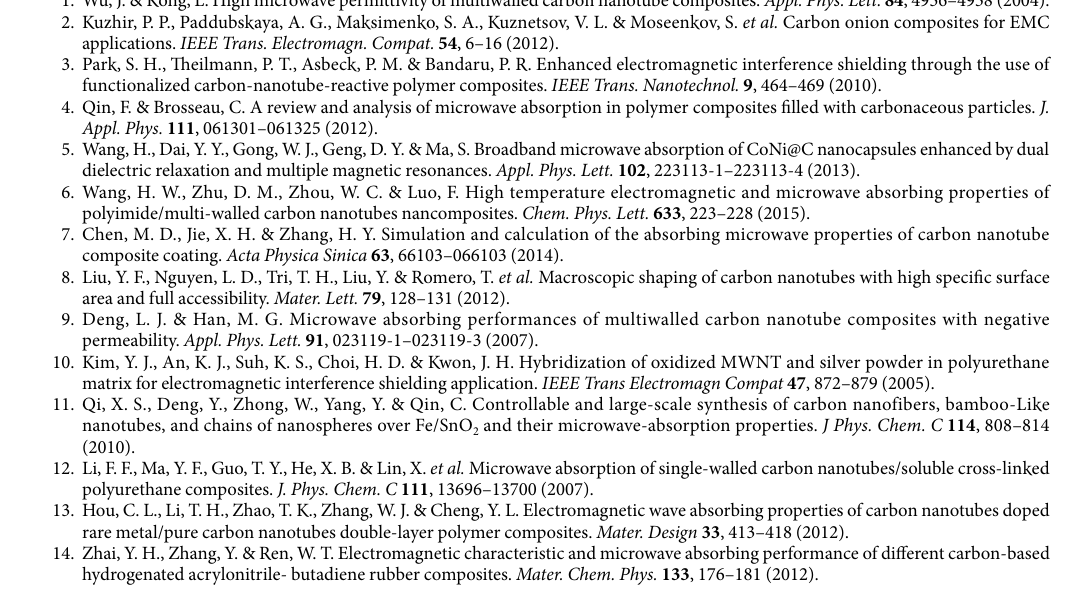
7 Scientific RepoRts | 7: 479 | DOI:10.1038/s41598-017-00372-9